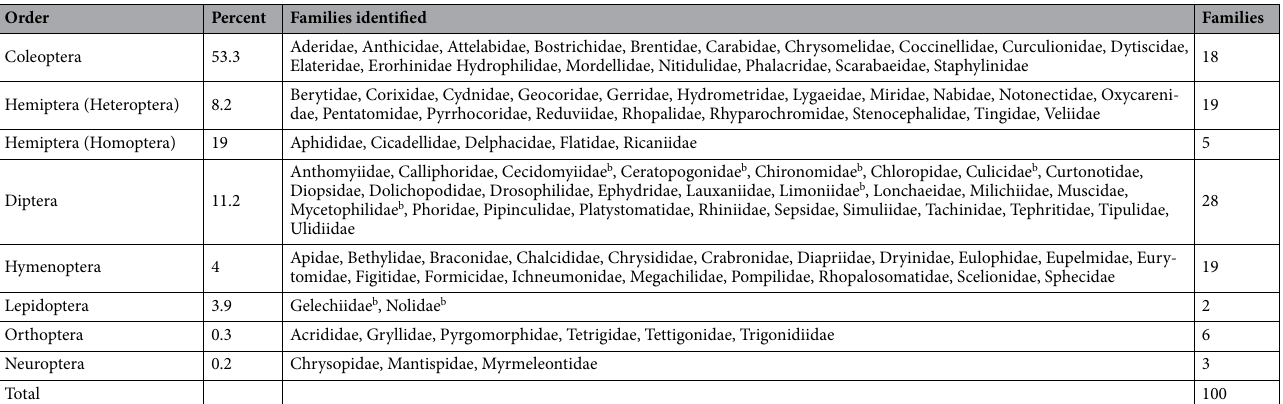
Table 1. Overall diversity of insects collected in aerial samples (40–290 m agl) as reflected by insect order composition (see also Fig. 2). The insect families sent for identification by taxonomists represent a small fraction of the predicted total diversity (see text). Orders represented by 1–2 specimens (Blattodea, Thysanoptera, Megaloptera, Psocoptera, and Phasmatodea) are not shown. a In total, 4,824 insects from 77 sticky nets (panels) were used to estimate the order composition. The full collection awaits additional study and the authors would be pleased to hear from readers who might be interested in undertaking further study of particular taxa. b Identified through DNA barcoding correlations by Dr. Yvonne-Marie